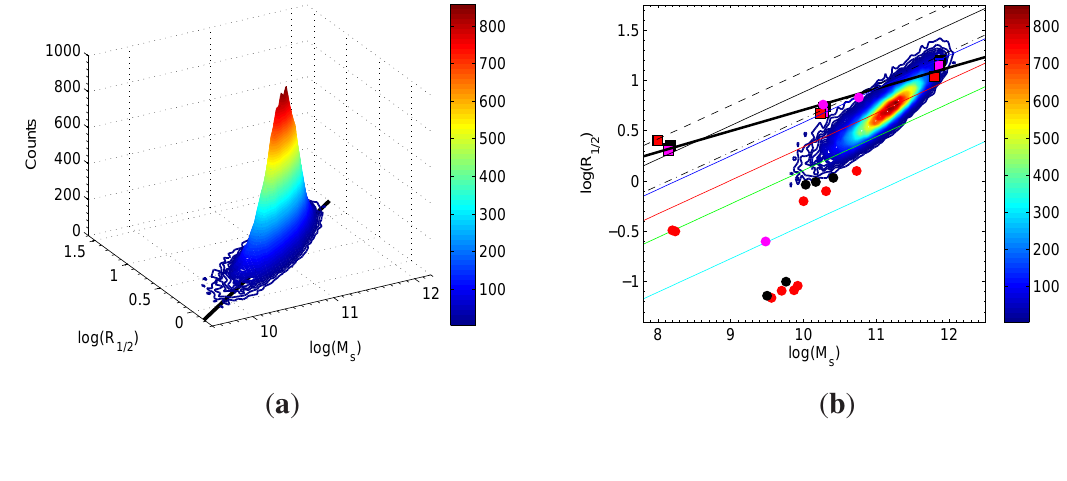
Figure 15. ( a ) 3D view of the MRR. The number frequency distribution of galaxies on the MR-plane: M is the total stellar mass in solar units and R is the half-mass radius in kpc, s 1 / 2 and “Counts” is the number of galaxies falling within each cell of the plane with dimensions = 0.05 and ∆ log R = 0.05. The data are from the HB sample of [227]. The ∆ log M 12 1 / 2 thick line on the MR-plane is the linear fit of the data: log R = 0 . 54 log M 5 . 25 ; 1 / 2 s − versus log M ( b ) Theoretical MRR, i.e. , log R . The filled squares are the reference s 1 / 2 models of Table 1 and the filled circles the ancillary models. The color code recalls the initial over-densities. However, as the entries of Table 1 are fully sufficient to identify the models, the correspondence color-code-initial density is superfluous here. The thick black line is the fit of the reference models. The thin straight lines are the theoretical MRR on which proto-galaxies of given DM over-density settle down at the collapse stage as a function of the redshift. The lines are given by Equation (6) from [232]: solid lines are for m = 10 and f = 1 ; the color code indicates different redshifts (black: z = 0 ; blue: z = 1 ; red: z = 2 . 5 ; σ green: z = 5 ; cyan: z = 20 ); the thin black dashed line is for m = 10 , f = 1 . 5 , and z = 0 ; σ Finally, the thin black dashed-dotted line is for m = 5 and f = 1 , and z = 0 . Adapted σ from